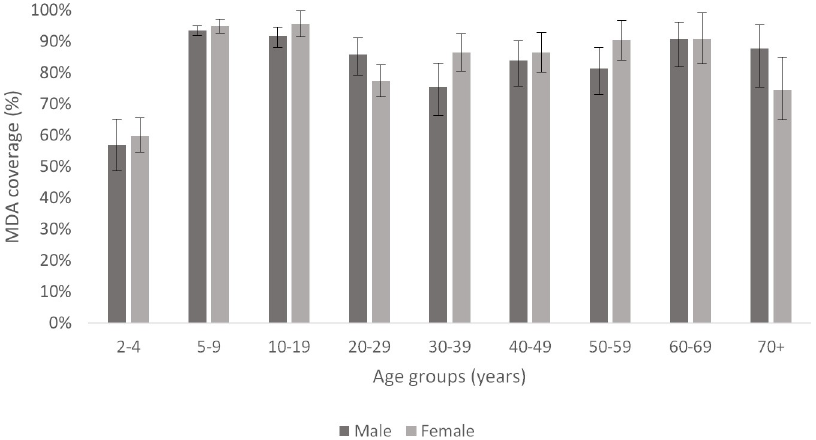
Fig 4. 2018 MDA coverage rates (of total population), grouped by age groups and sex. Error bars represent 95% confidence intervals.